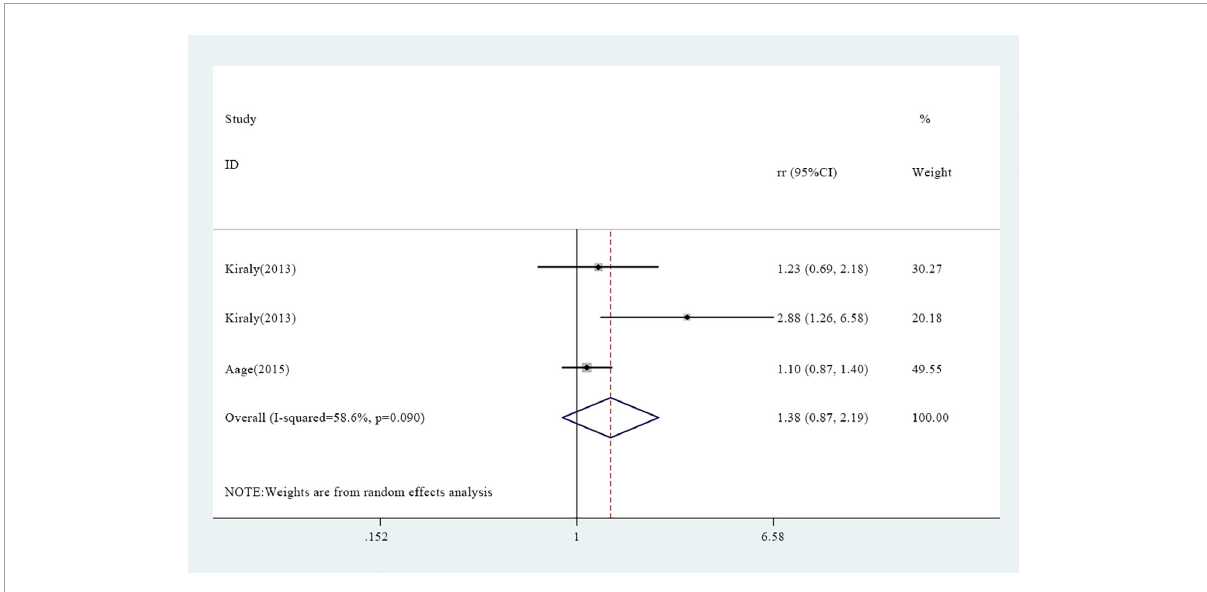
FIGURE2 Association between vitamin A supplementation and rapid atopy.